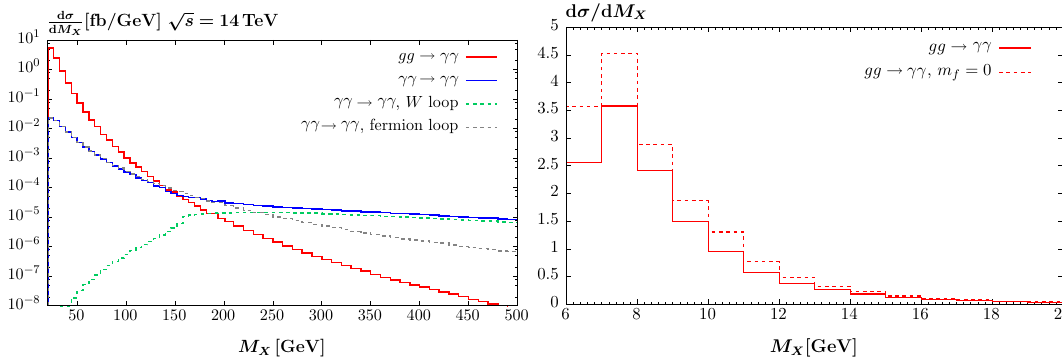
√ s = 14 TeV. The left plot in addition